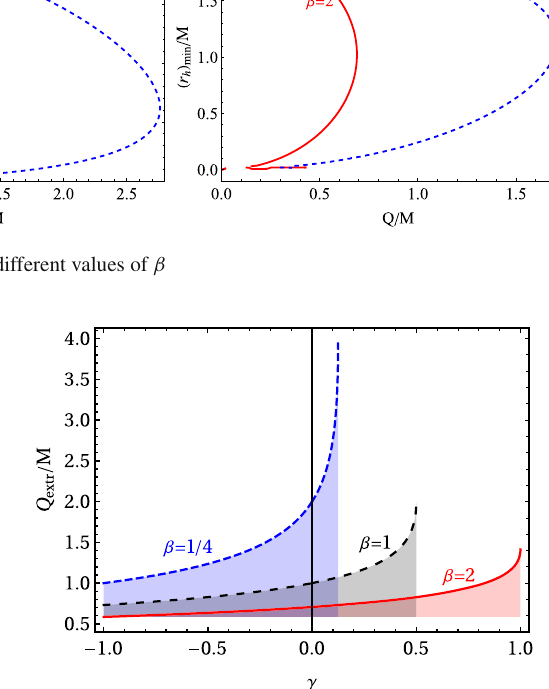
Fig. 2 Critical values of the BH charge as a function of the parameter γ for the different values of